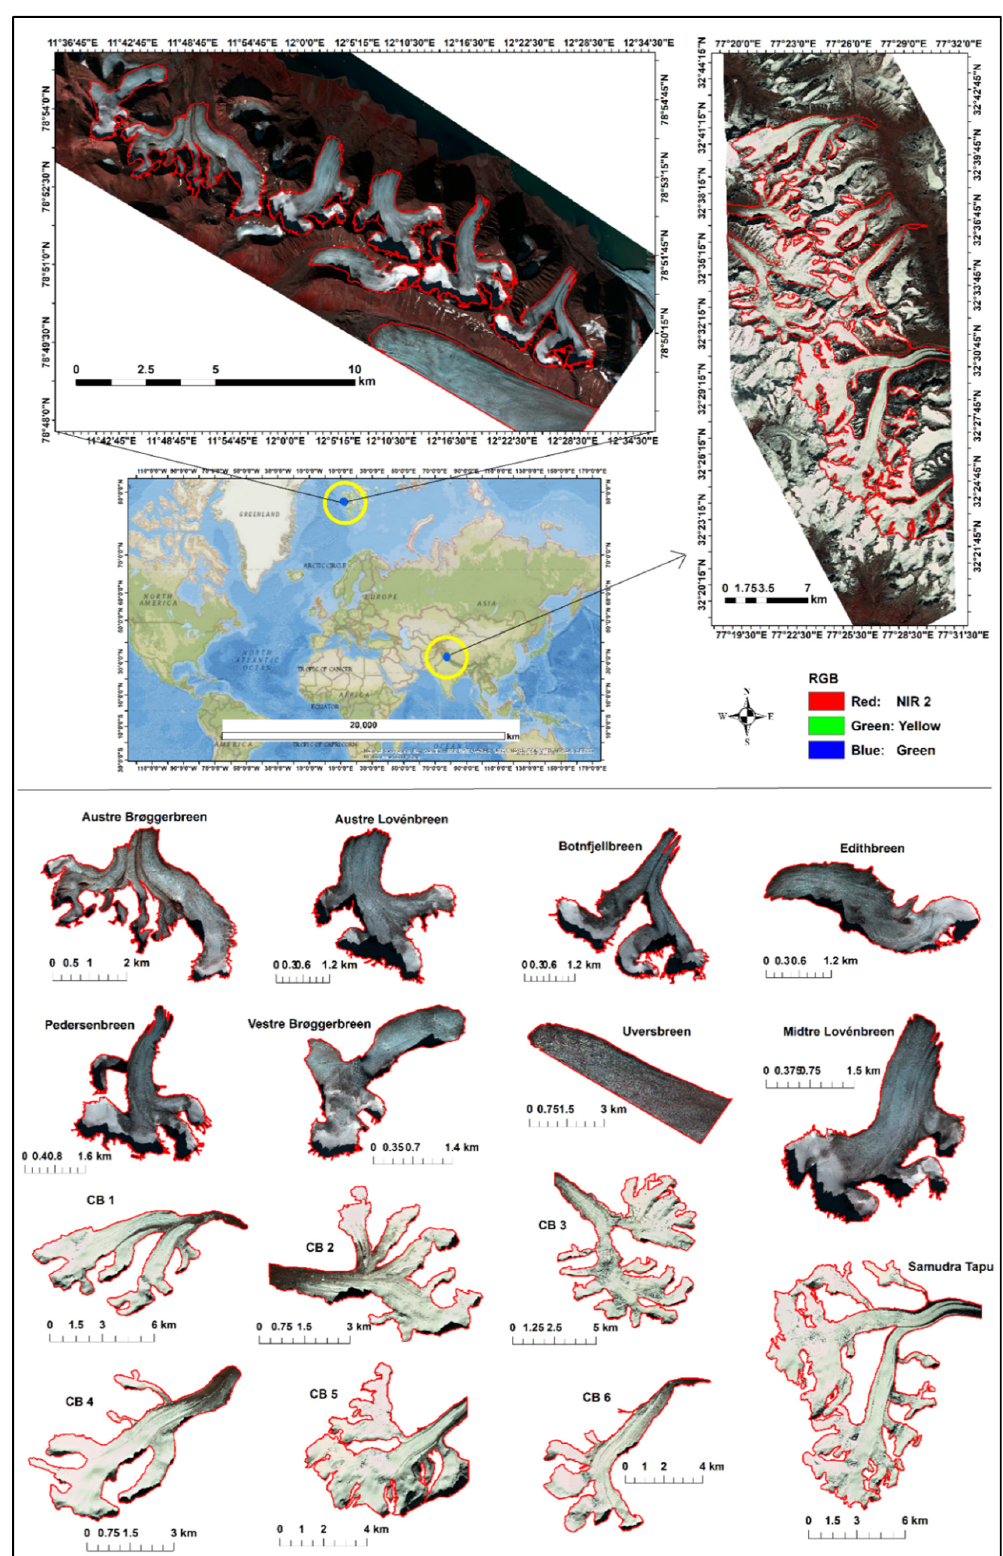
Figure 1. Location of the test sites ( upper section) and insets of the selected glaciers ( lower section). The satellite imagery used in the manuscript was obtained from Digital Globe, Inc., Westminster, CO, USA. Chandra–Bhaga basin image: imagery © 2014 Maxar; Ny-Ålesund image: imagery © 2016 Maxar.